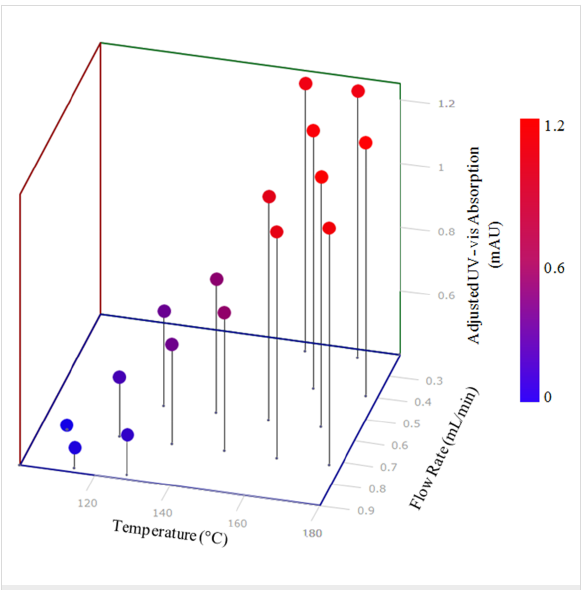
Figure 9: Optimisation plot for the SIMPLEX optimisation of the fused polycyclic heterocycle 5 . Two optimal data points at 0.24 mL/min and 156 °C, and 0.24 mL/min and 170 °C were found.